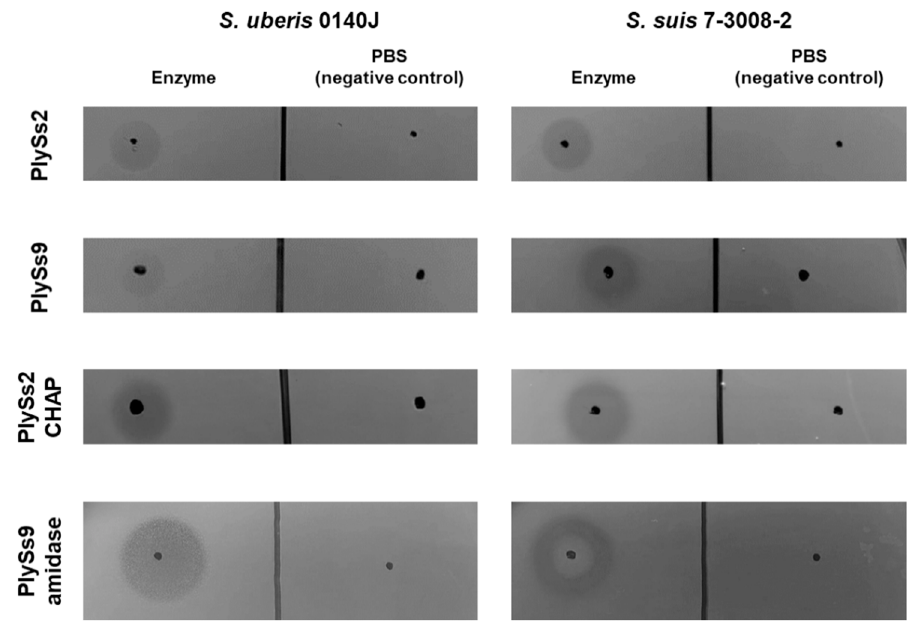
Figure 2. Qualitative spot-on-plate assays of PlySs2, PlySs9, PlySs2 CHAP and PlySs9 amidase on S. uberis 0140J and S. suis 7-3008-2 after incubation during 18 h at 37 ◦ C. S. suis was included as positive control, phosphate bu ff ered saline (PBS) served as negative